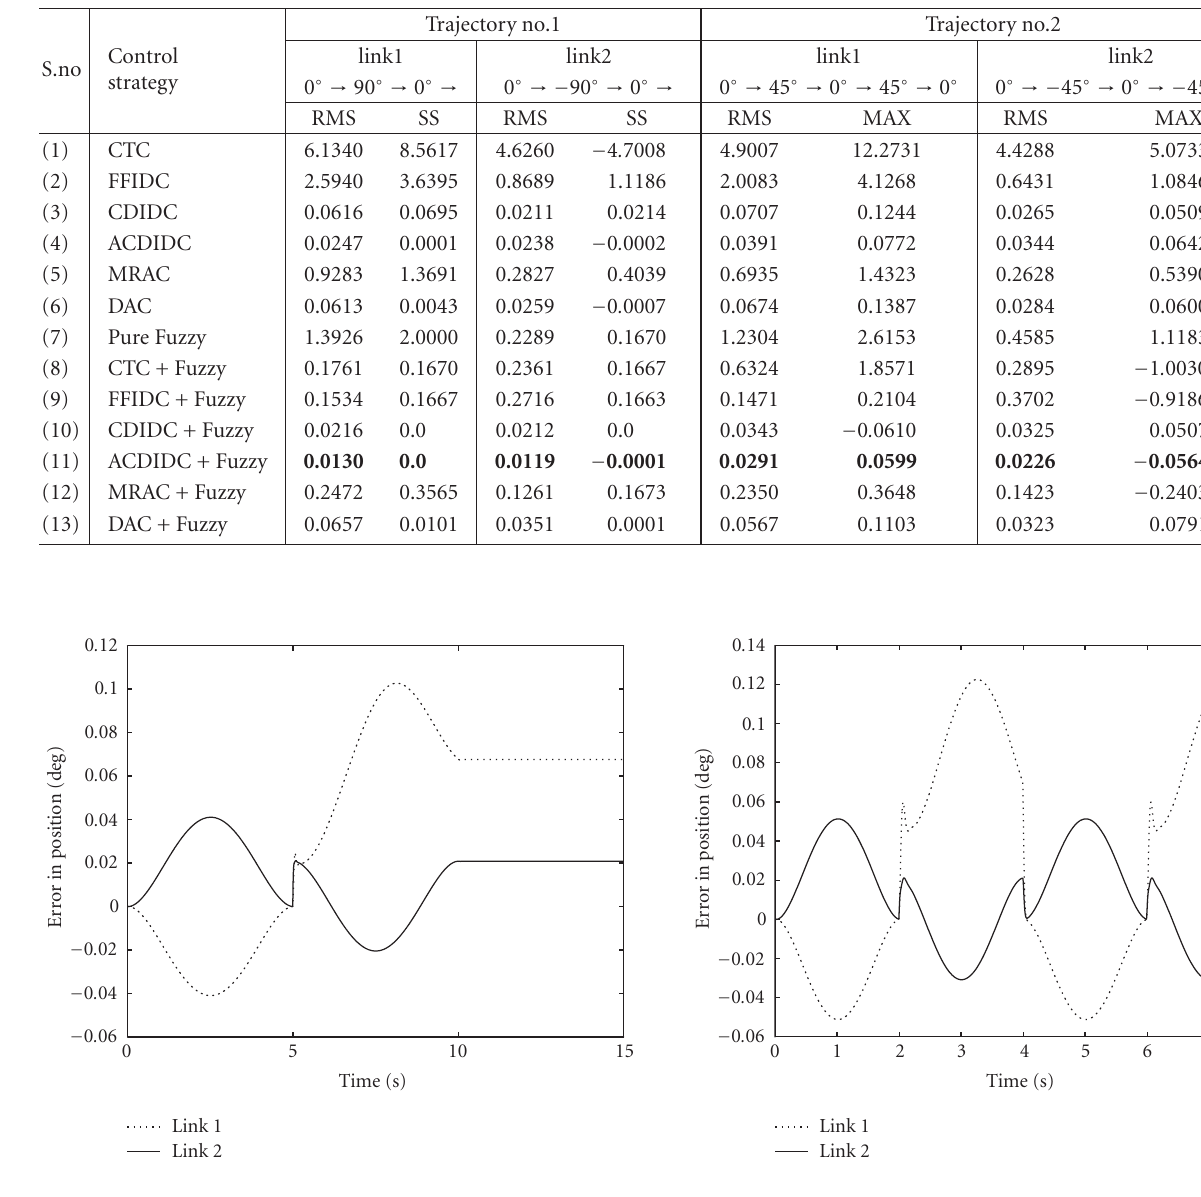
Figure 8: CDIDC errors for trajectory 1. Figure 9: CDIDC errors for trajectory